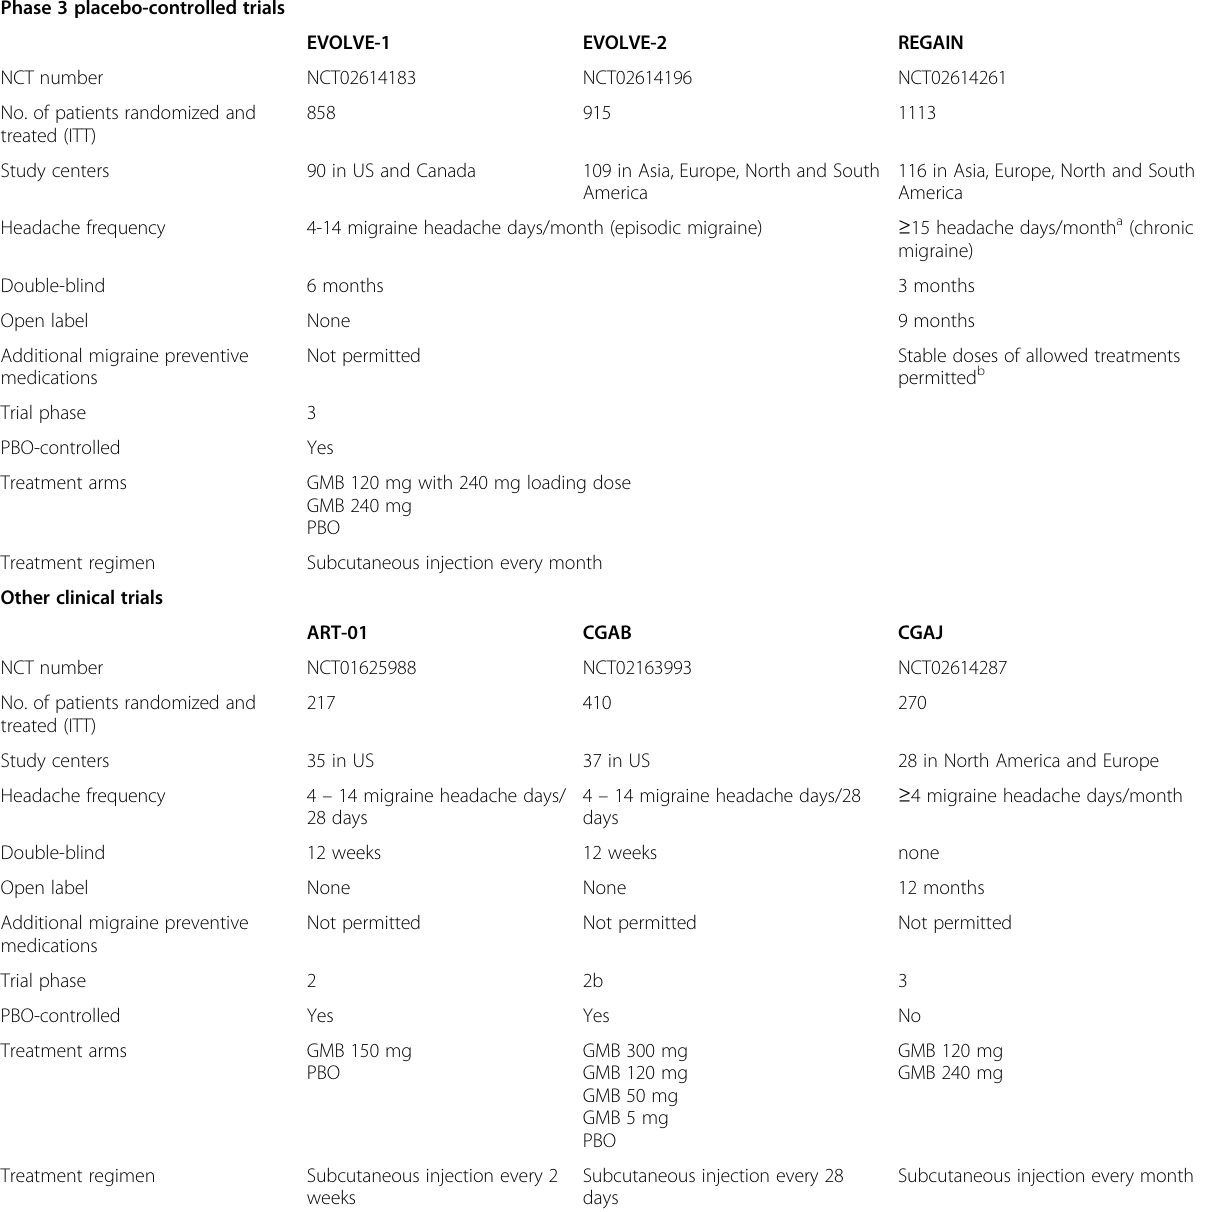
Table 1 Clinical trials included in analyses Phase 3 placebo-controlled